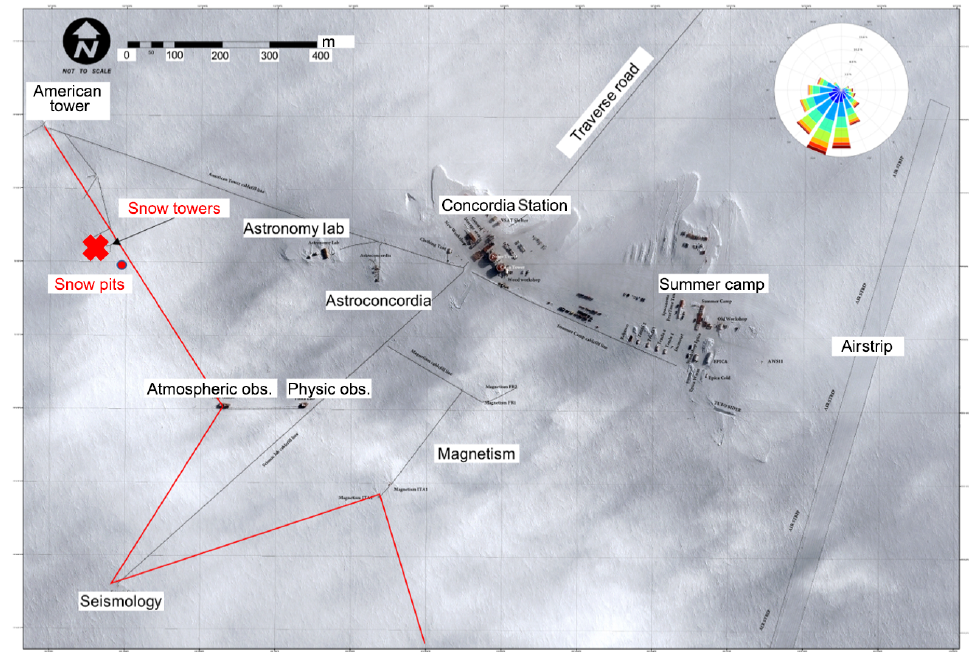
Figure 1. Satellite image of research station Concordia with location of the snow photochemistry experiment indicated by the red text and cross marker. Its location was ∼ 1km west of the station main buildings and power generation plant. The map also indicates the location where the snow pits were collected, the border of the clean air sector (which is west of the red line), and a wind rose for a full year of wind data collected from the met tower that was adjacent to the snow tower manifolds (Pléiades satellite image courtesy of Airbus Defence and Space SAS, CNES, 2016).